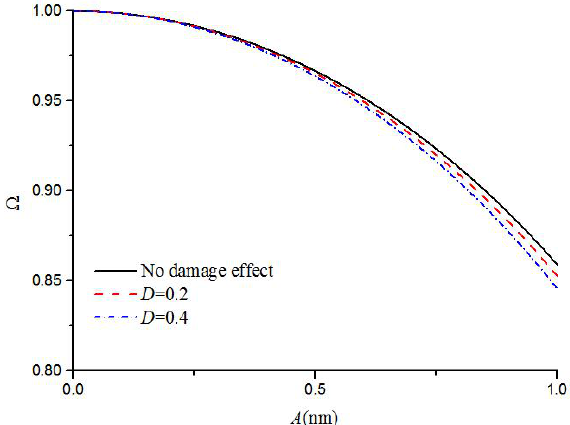
Fig. 2. The effect of damage to the amplitude-frequency response Table 1. The relationship between amplitude and frequency